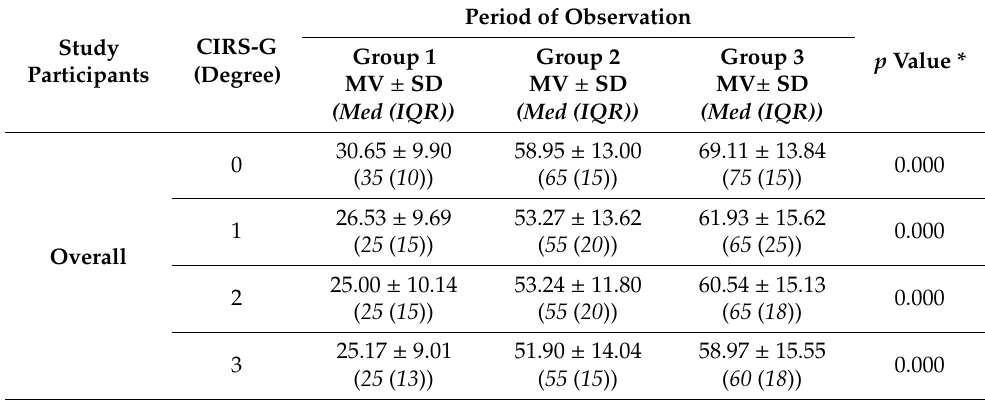
Table 2. SF-36 PFC mean values in di ff erent time of observation for separate CIRS-G parameters regarding severity